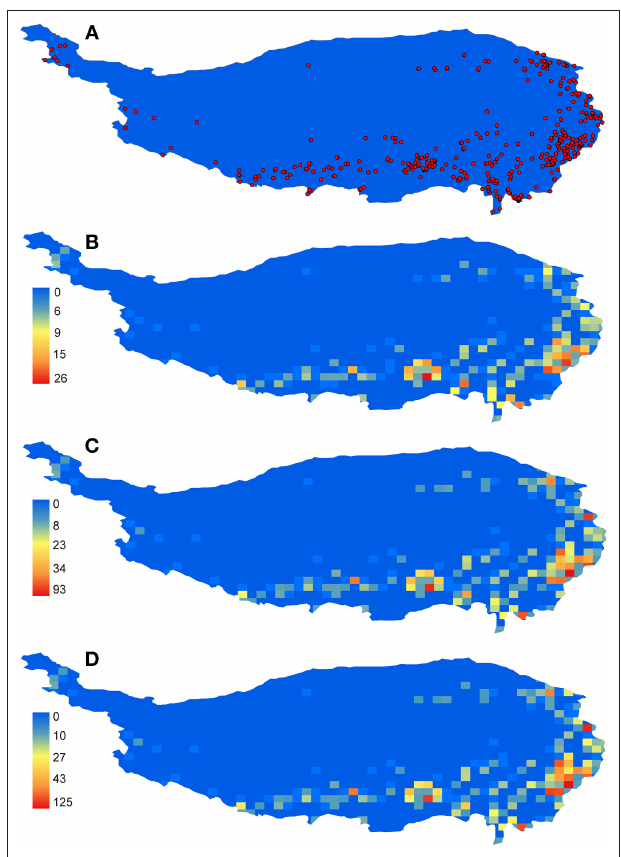
FIGURE 1 | The distribution and richness patterns of Hemipteran insects in the QTP. (A) all records, (B) family richness, (C) genus richness, and (D) species